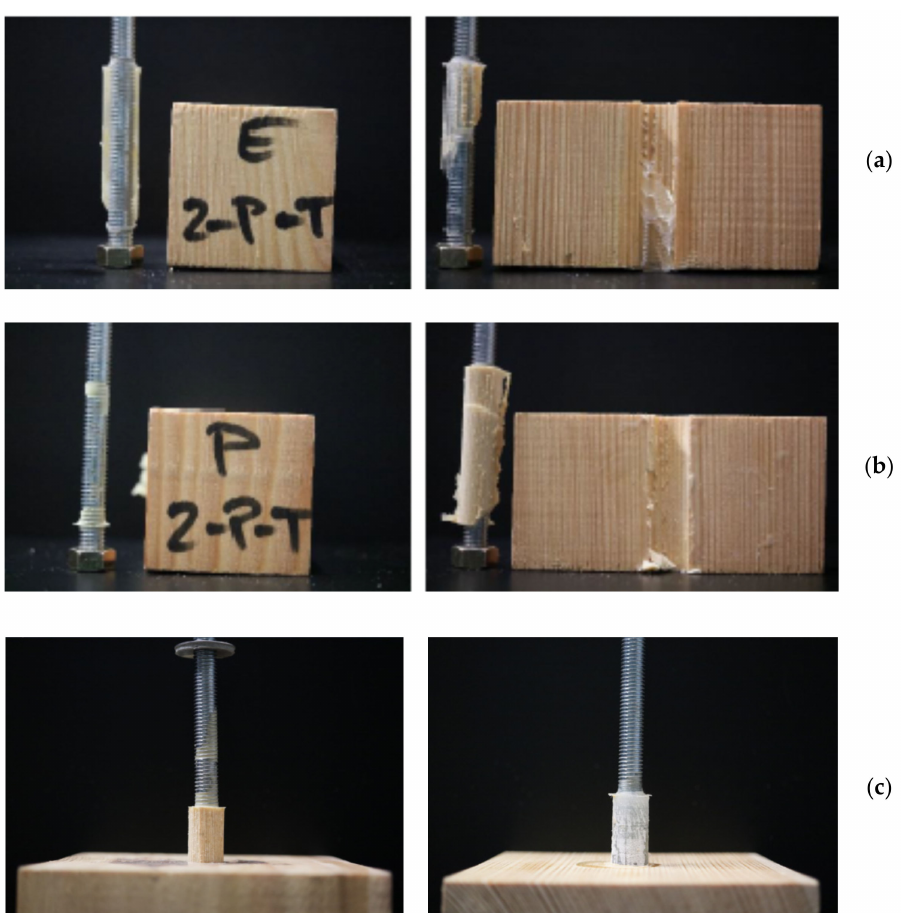
Figure 6. Example of failure configuration for the tested samples: ( a ) epoxy and ( b ) polyurethane bonded rods for half-size specimens (18% moisture, parallel rod-to-grain arrangement) and ( c ) full-size specimens.